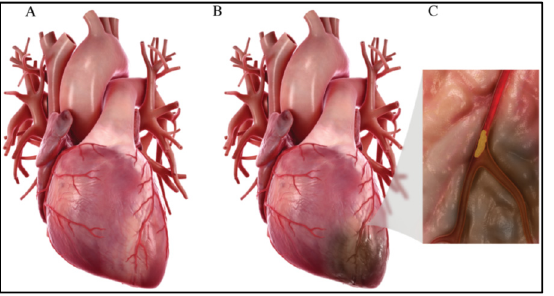
Figure 1. ( A ) Normal heart. ( B ) Heart after myocardial infarction, where an ischemic region is developed due to no/reduced blood flow to that cardiac region. ( C ) Plaque accumulation in the coronary artery that leads to its blockage [3].